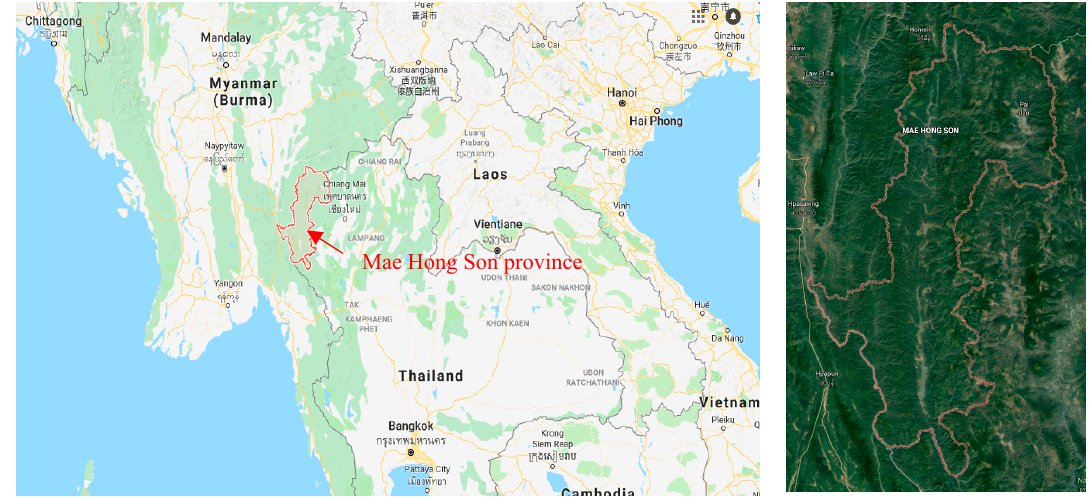
Figure 1. Location of Mae Hong Son, Thailand [19].